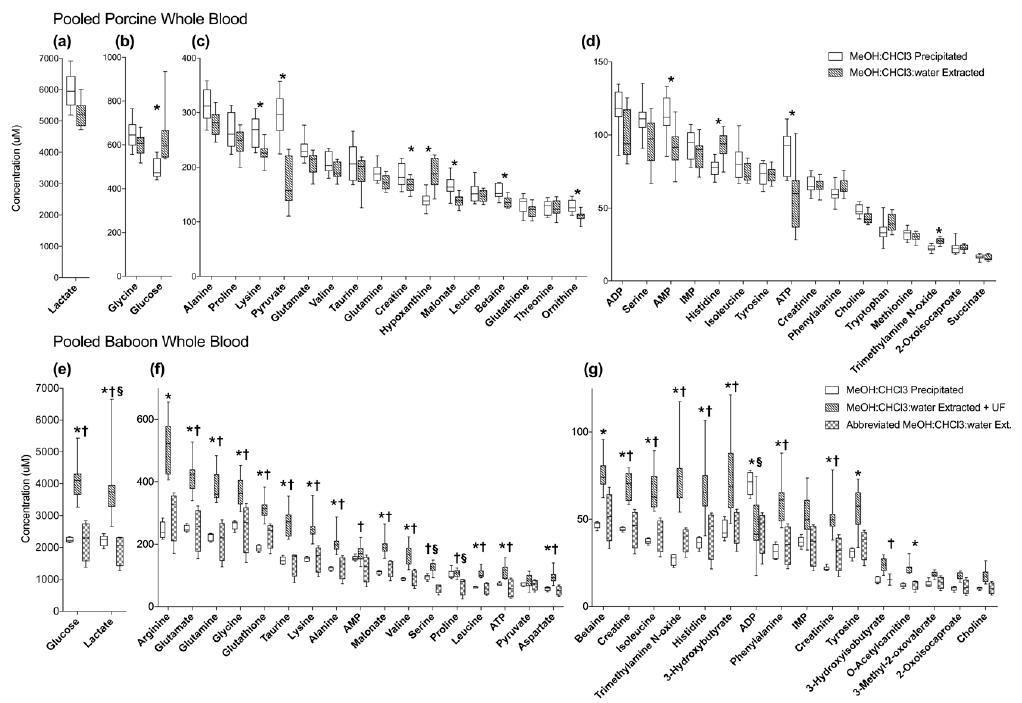
Figure 4. Metabolites ( µ M) detected by 1 H-NMR (500 MHz) spectroscopy in pooled pig WB ( a – d ) and pooled baboon WB using different macromolecule removal strategies ( e – g ). Box plots of samples ( n = 10 in both pig WB conditions; n = 4 for MeOH:CHCl 3 :water ppt and abbreviated MeOH:CHCl 3 :water ext baboon WB, n = 10 for MeOH:CHCl 3 :water ext +UF baboon WB) represent the interquartile range with the cross-bar being the median; and whiskers are minimum and maximum concentrations. * indicates p ≤ 0.05 between MeOH:CHCl 3 ppt versus MeOH:CHCl 3 :water ext +UF, § between versus MeOH:CHCl 3 :water ext.